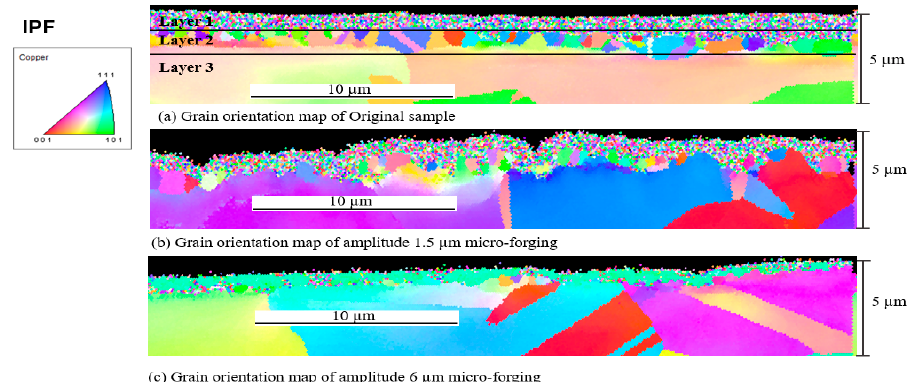
Figure 14. Grain orientation map at a surface scale of 5 μ m.